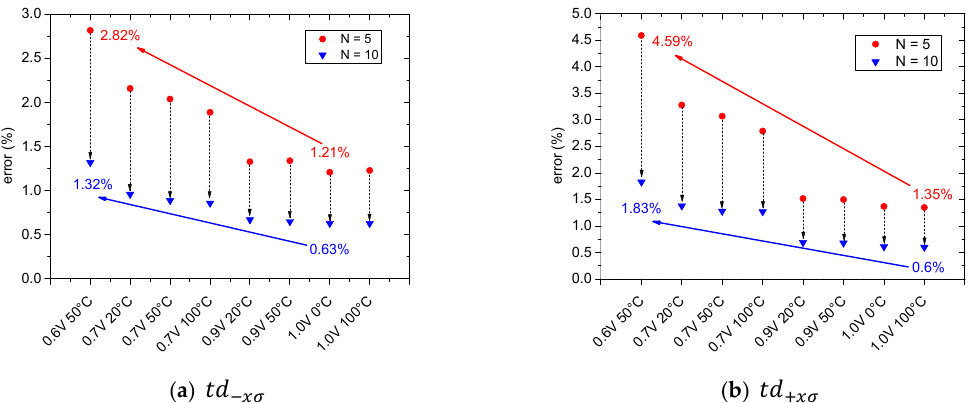
Table 4. Comparison with previous works.